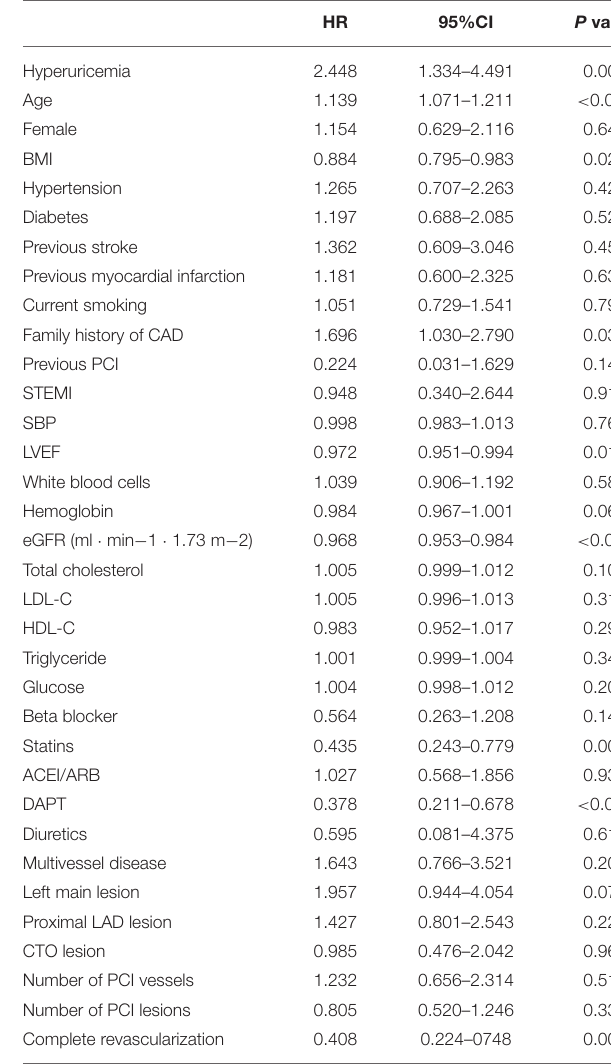
TABLE 1 | Baseline characteristics. TABLE 2 | Univariate analysis for all-cause